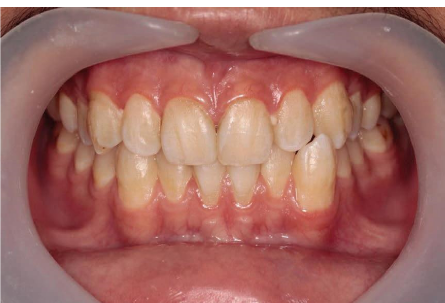
Figure 4: Teeth after bleaching with hydrogen peroxide whitening gel at the end of the fnal appointment.